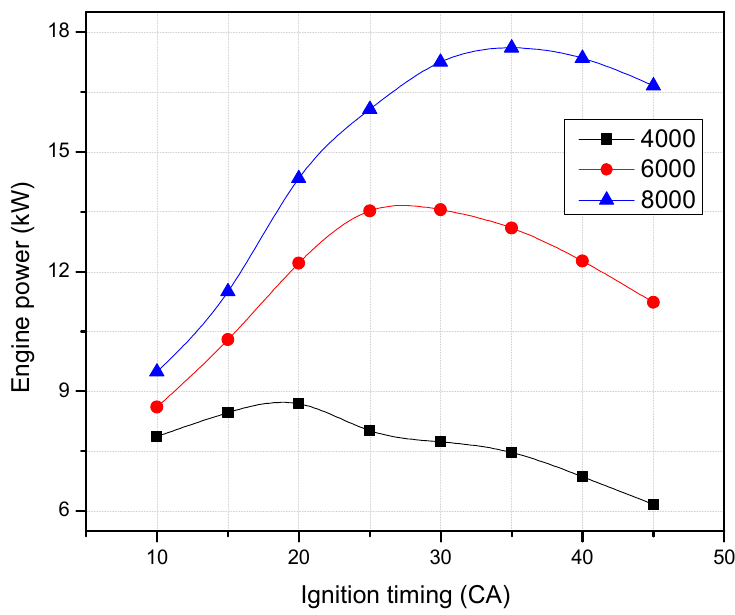
Figure 17. Engine power versus ignition timing.